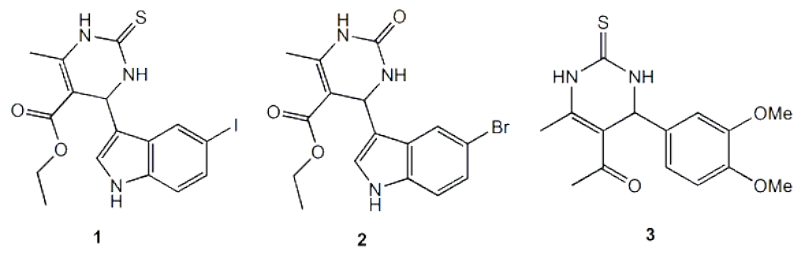
Figure 1. Examples of pharmacologically active dihydropyrimidinones (DHPMs).